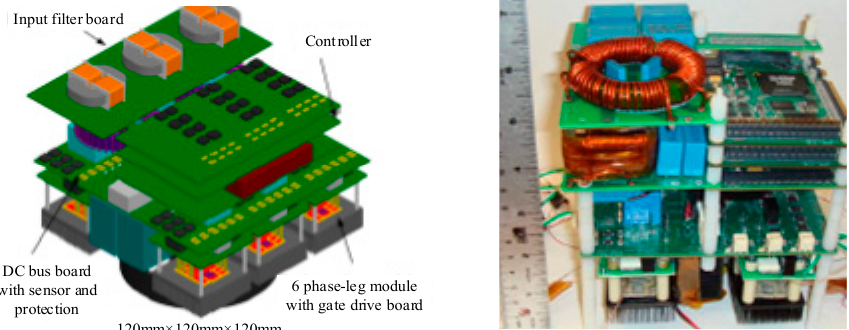
Figure 13. Conceptual drawing and the assembled prototype rectifier system